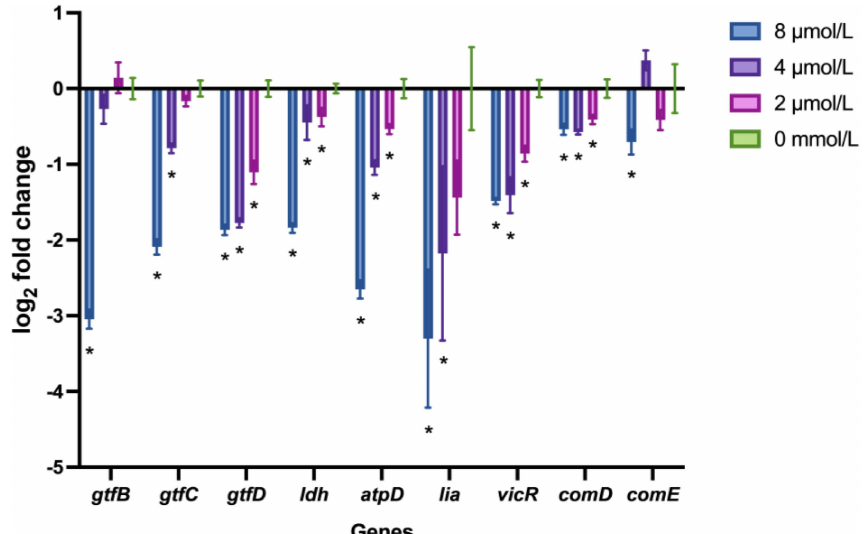
Figure 4. The expression profiles of the Streptococcus mutans virulence-associated genes under LF-1 treatment were evaluated by real-time quantitative PCR. The gene expressions are presented as log 2 fold change (mean ± standard deviation) normalised to 16S rDNA gene transcription from at least three independent experiments. Asterisks (*) indicate a significant statistical difference from the untreated control (two-way analysis of variance; p <